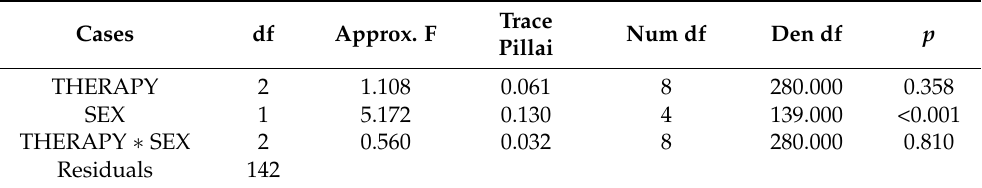
Table 1. MANOVA results show a significant effect of gender (sex) on the dependent variables, i.e., the scores to the various